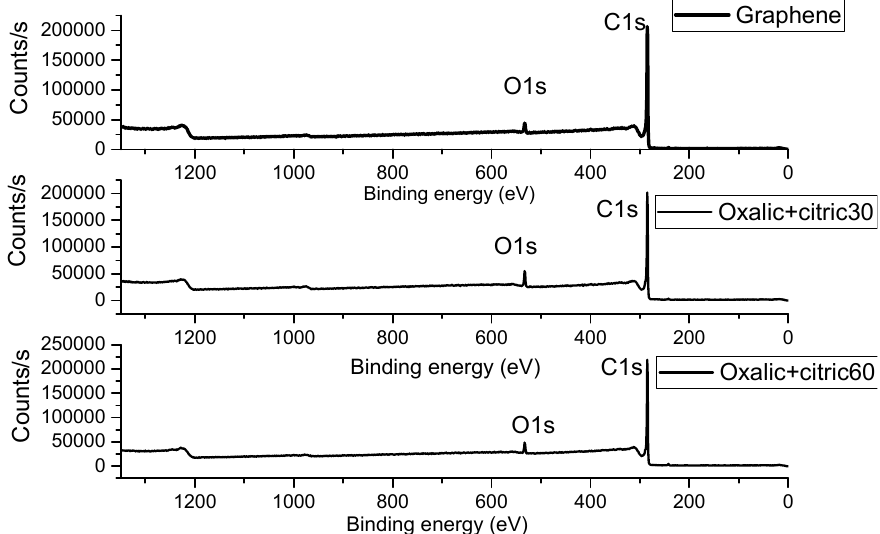
Figure 3. XPS spectrum of unmodified graphene and modified graphene with Oxalic+Citric30 and Oxalic+Citric60.